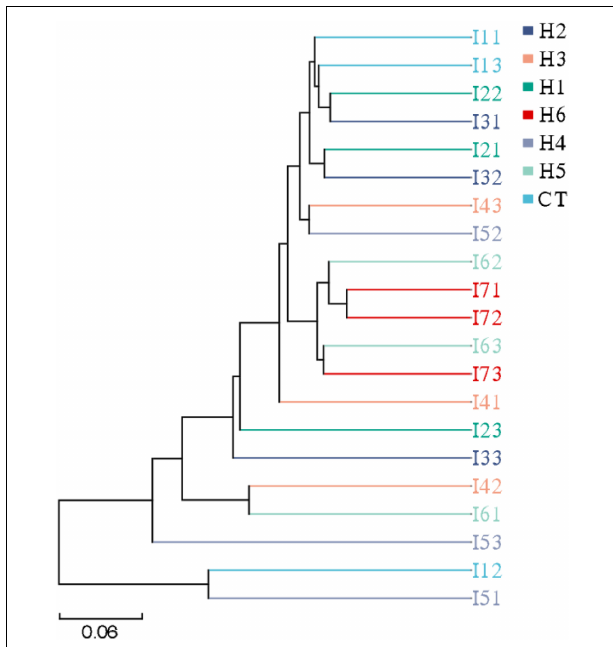
FIGURE 6 | Unweighted pair group method with arithmetic mean-clustering tree of juvenile pearl gentian hybrid grouper fed with different levels of HFP.